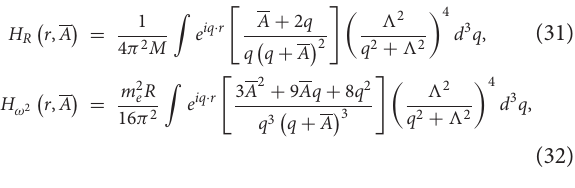
( r ) for the 0 νβ − β − and 0 νβ − β − χ decay modes of 130 Te isotope. ω 2